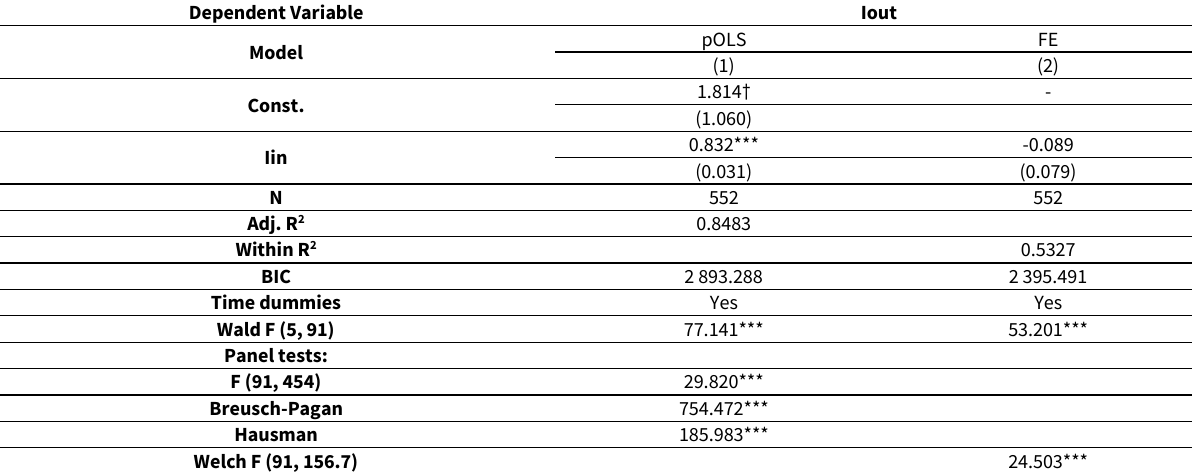
Table 7. Results of regressions Dependent Variable